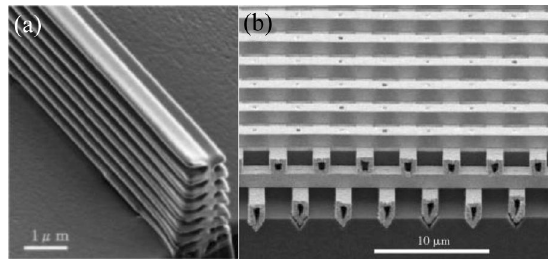
Figure 13 Preparation by chemical vapor deposition: a SIM image of morpho butterfly scale pseudostructure [72]; b SEM image of 3D tungsten photonic crystal